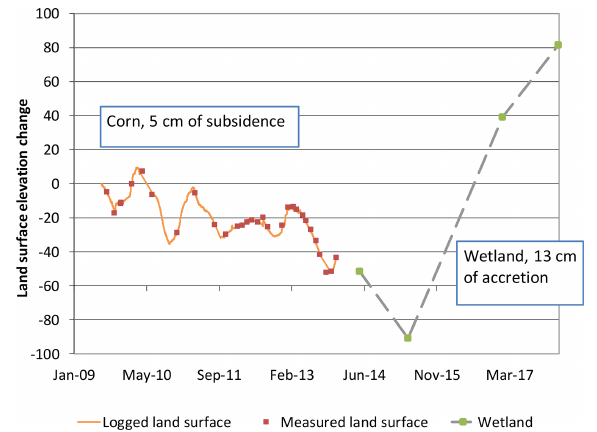
Figure 4. Subsidence and the wetland trajectory reversal in land